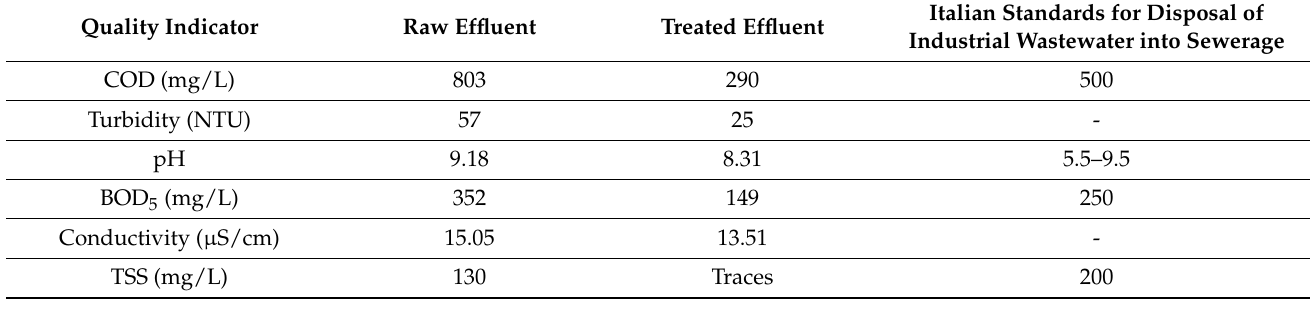
Figure 10. Photograph of ( a ) fresh catalyst, ( b ) catalyst after adsorption, ( c ) catalyst after three regeneration cycles. Table 5. Main characteristics of the textile effluent before and after the photo-Fenton process, and comparison with Italian standards for industrial wastewater disposal into sewerage (D.Lgs 152/2006).